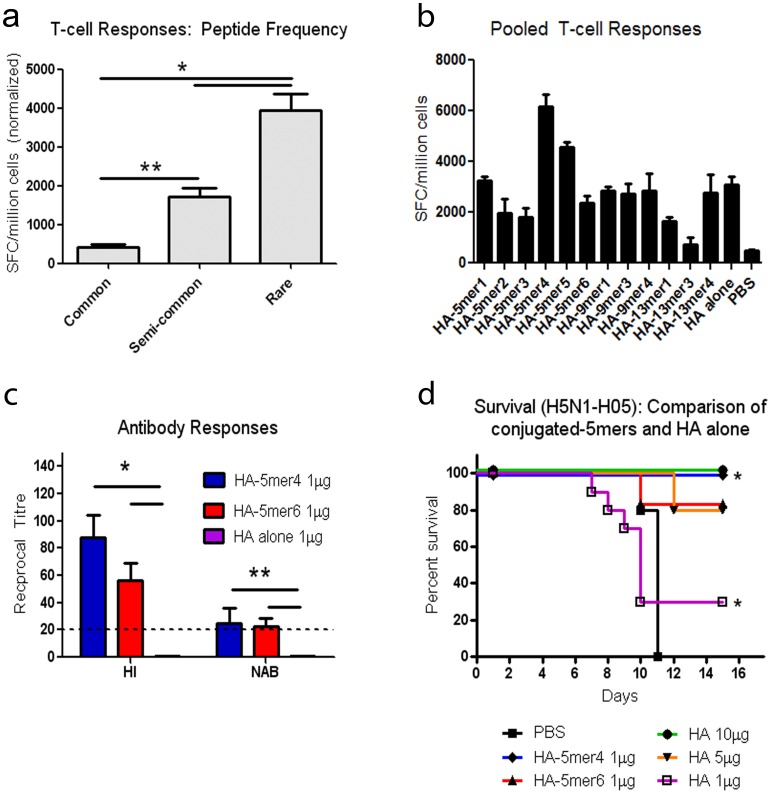
Immune responses and protection following conjugation of rare occurring peptides to the H5N1-HA antigen C-terminus.Individual 5-mer, 9-mer, or 13-mer peptides consisting of amino acids that occur rarely or never in sequence were added to the end of the H5N1-HA antigen by PCR. (a) Pooled T-cell immune responses generated by rare, semi-common, and common peptides. Groups of 3–4 BALB/c mice were immunized with pools of 10 peptides representing 200 rare, 200 semi-common, and 200 common peptides and cellular immune responses were detected 10 days post-vaccination by visualization of IFN-γ secretion by spot forming cells (SFC). The data, representing the average SFC in each category of peptide, is representative of 3 independent experiments and is normalized based on comparison with the HA DNA vaccine alone to distinguish changes with respect to peptide frequency. The average SFC baseline from unstimulated control splenocytes is (40±8). (b) T-cell responses following vaccination. Groups of 4 BALB/c mice were immunized with 50 µg of each HA-peptide construct and cellular immune responses were detected 10 days post-immunization. (c) Hemagglutination inhibition and neutralizing antibody responses at day 25 post-vaccination. Serum was individually evaluated from 8–10 BALB/c mice immunised with HA-5mer4 (1 µg), HA-5mer6 (1 µg), or HA alone (1 µg). HI antibody titres were detected using horse red blood cells. NAB titres were evaluated by monitoring MDCK cells for the presence of CPE. The dotted line represents the limit of detection of the HI and NAB assays. (*p<0.0001, **p<0.0001) (d) Survival against lethal H5N1-H05 challenge. Groups of 10 BALB/c mice were immunized with control PBS ▪, HA-5mer4 (1 µg) ♦, HA-5mer6 (1 µg) ▴, or H5N1-HA (1□, 5 ▾, or 10 µg •) and then challenged with 100LD50 of homologous H5N1-H05 virus. Animals were monitored over a period of 15 days. (*p<0.01) Error bars represent the standard error of the mean (SEM).